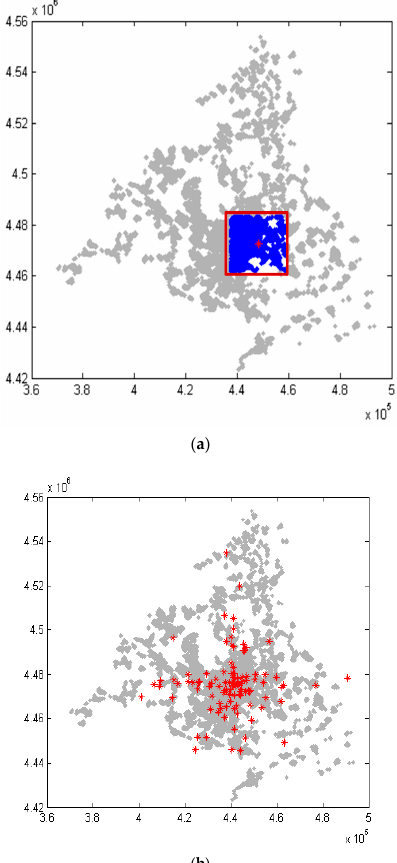
Figure 1. ( a ) Validation square regions; and ( b ) analyzed central points for validation process.